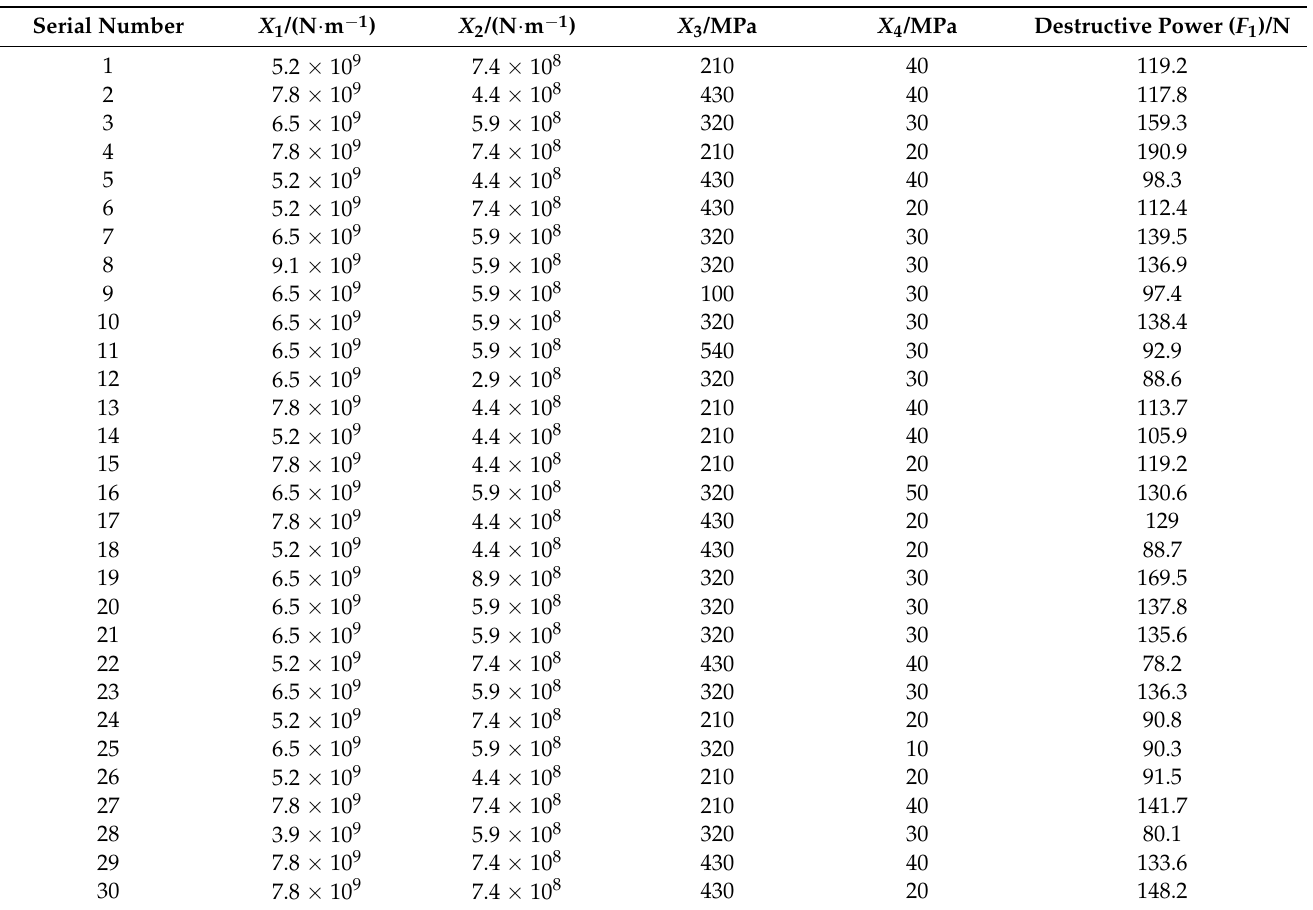
Table 4. Simulation test design and results of epidermal bonding